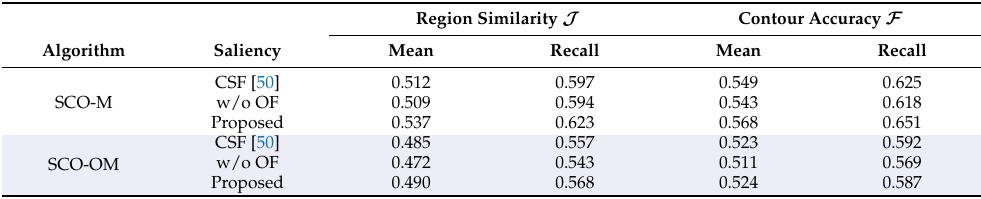
Table 4. Ablation studies on the validation set in DAVIS2017: ‘w/o SOTR’ and ‘w/o DD’ mean that the salient object track refinement and the disappearance detection are not used, respectively.